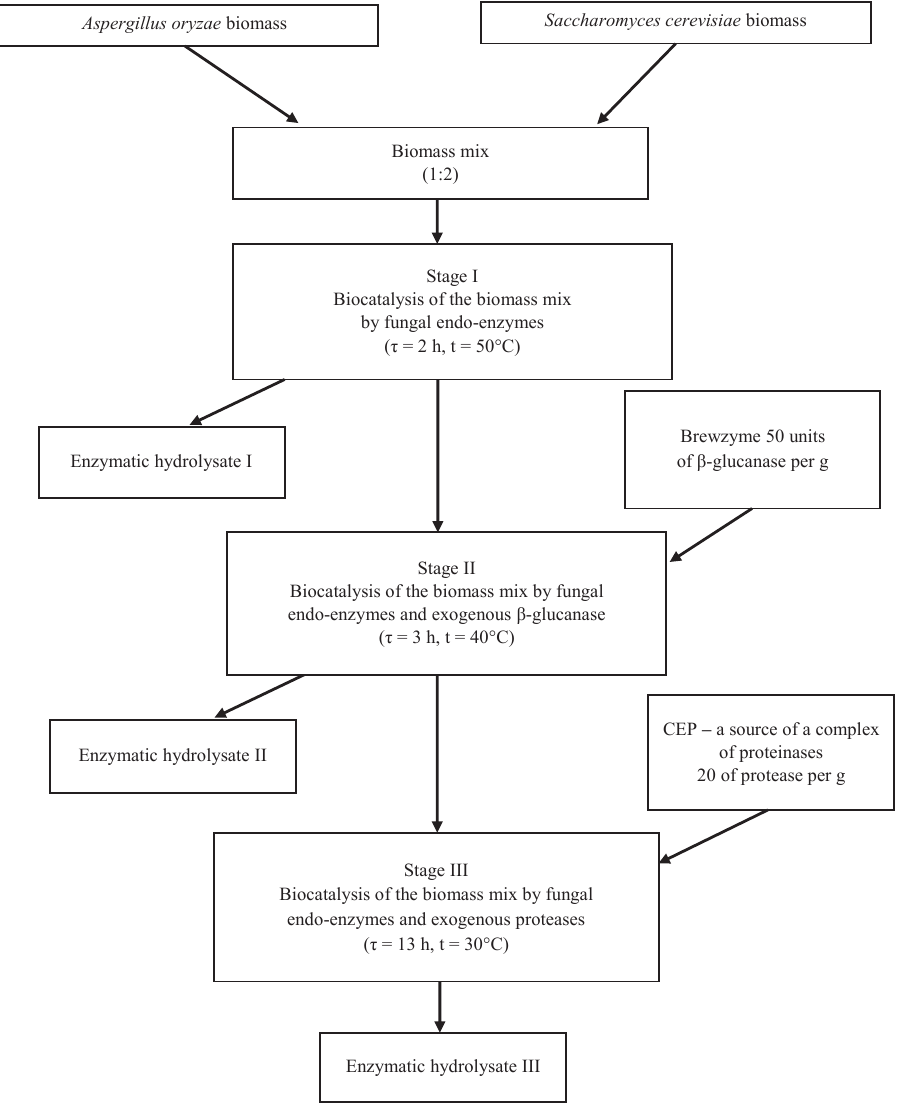
Figure 2 Biocatalytic conversion of the microbial biomass mix ( Aspergillus oryzae and Sаcharomyces cerevisiae